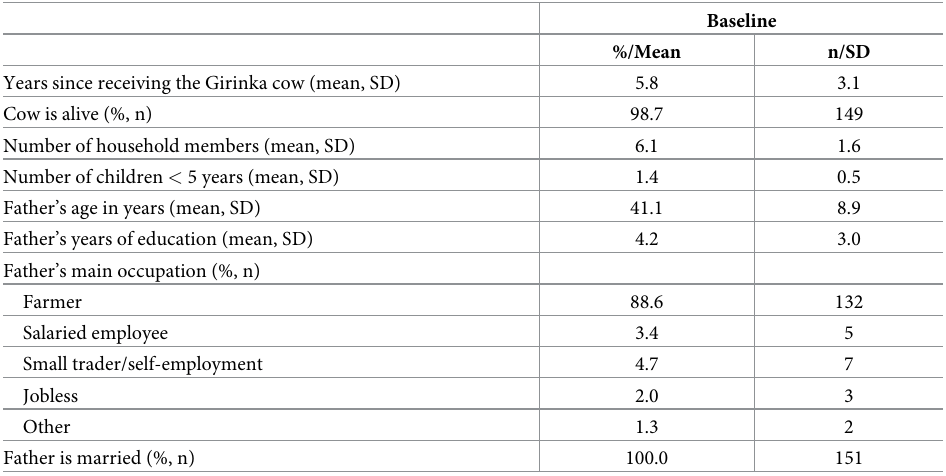
Table 1. Father and household characteristics at baseline (N =